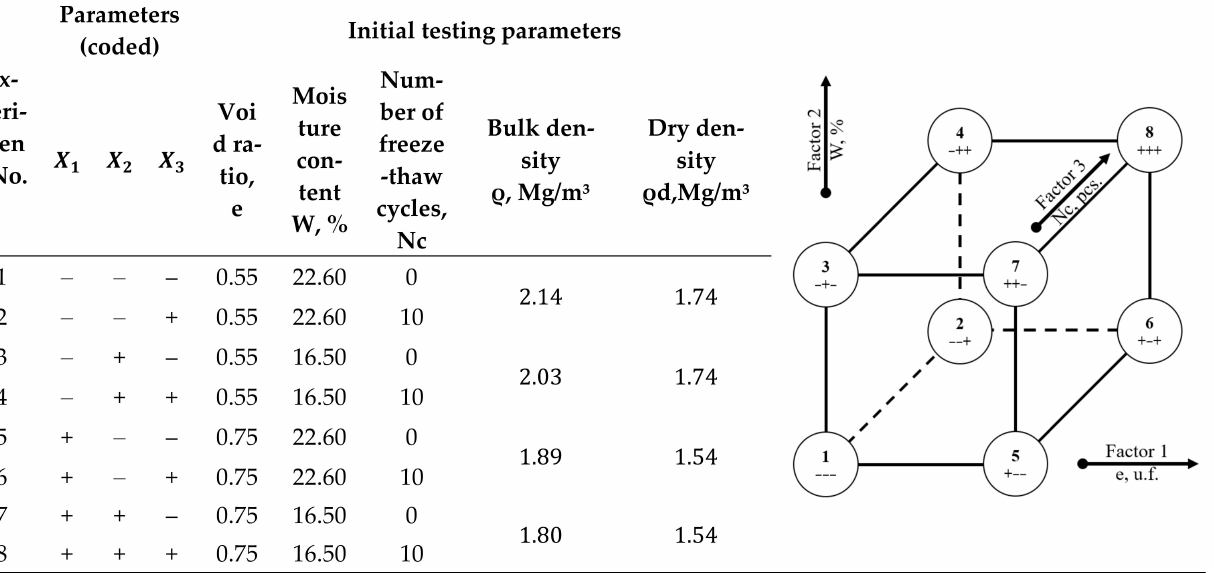
Figure 1. Graphical representation of the experiment matrix.